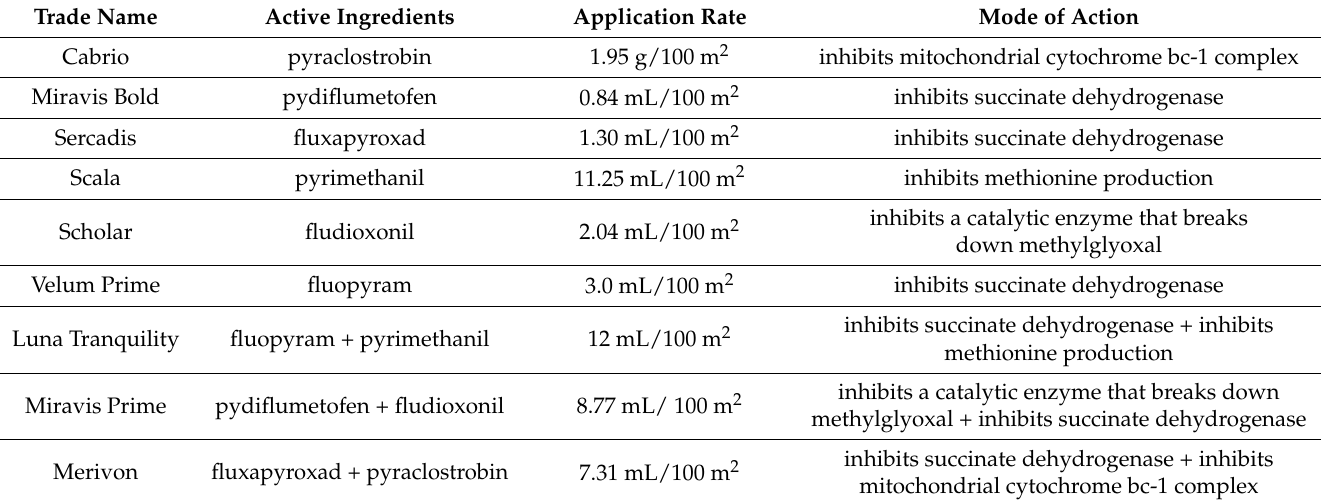
Table 1. List of fungicides used in this